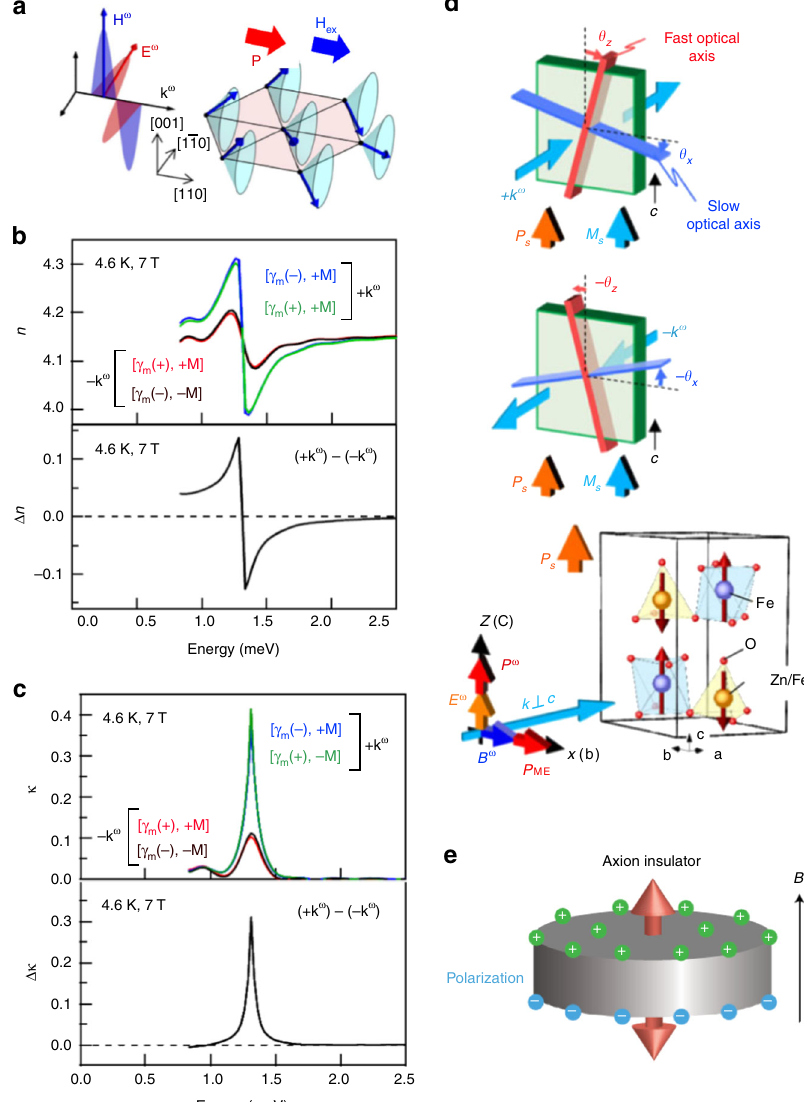
Fig. 1 Magnetochiral dichroism and gyrotropic birefringence (GB) in multiferroics. a Schematic illustration of the conical screw spin structure under an external magnetic fi eld ( H ex ) in multiferroic CuFe 1 – x Ga x O 2 ( x = 0.035). The H ex parallel to the in-plane magnetic modulation q m (e.g., // [110]) modi fi es the proper screw spin structure to the conical one. The ferroelectric polarization ( P ) driven by the screw spin structure also points to the in-plane q m direction ([110]). The electromagnon spectra of ( b ) real part n ( ω ) and ( c ) imaginary part κ ( ω ) of the complex refractive index at 4.6 K and 7 T ( H ex || [110]) with the light con fi guration in ( a ). Spectra with both signs of spin helicity ( γ m ( + ) or γ m ( – )) and magnetization ( + M or – M ) are shown. In the respective lower panels, magnetoelectric spectra are shown de fi ned as ( b ) Δ n ( ω ) = n ( + k ω ) – n ( – k ω ) and ( c ) Δ k ( ω ) = κ ( + k ω ) – κ ( – k ω ) 12 . d Schematic of GB for light with propagation vector + k ω (upper) and − k ω (bottom) perpendicular to the c axis in the case of (Fe; Zn) 2 Mo 3 O 8 ; P s and M s stand for the spontaneous electric polarization and magnetization. P ω and P ME show the electric polarizations induced by the electric fi eld ( E ω ) and magnetic fi eld ( B ω ) of light, respectively. The green plate and red and blue bars denote the sample and rotating principal optical axes, respectively. Reprinted fi gure with permission from ref 18 . Copyright (2017) by the American Physical Society. e Axion insulator potentially showing the topological magnetoelectric effect and associated GB, composed of the magnetic topological insulator with the opposite magnetization directions on the top and bottom layers. Figure from ref. 21 with permission from Nature Publishing